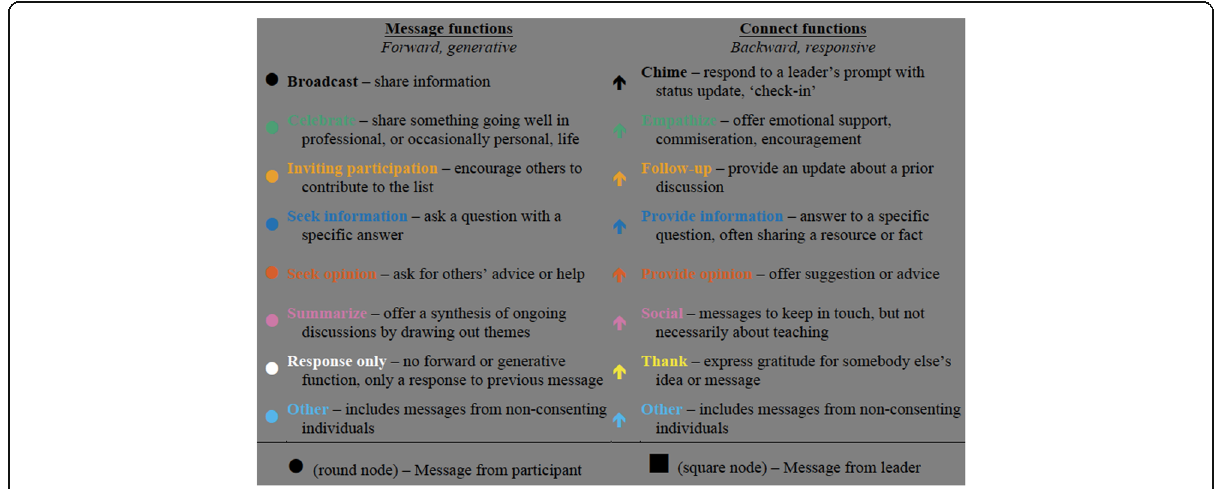
Fig. 2 Common key of m essage function and c onnect function categories for all network